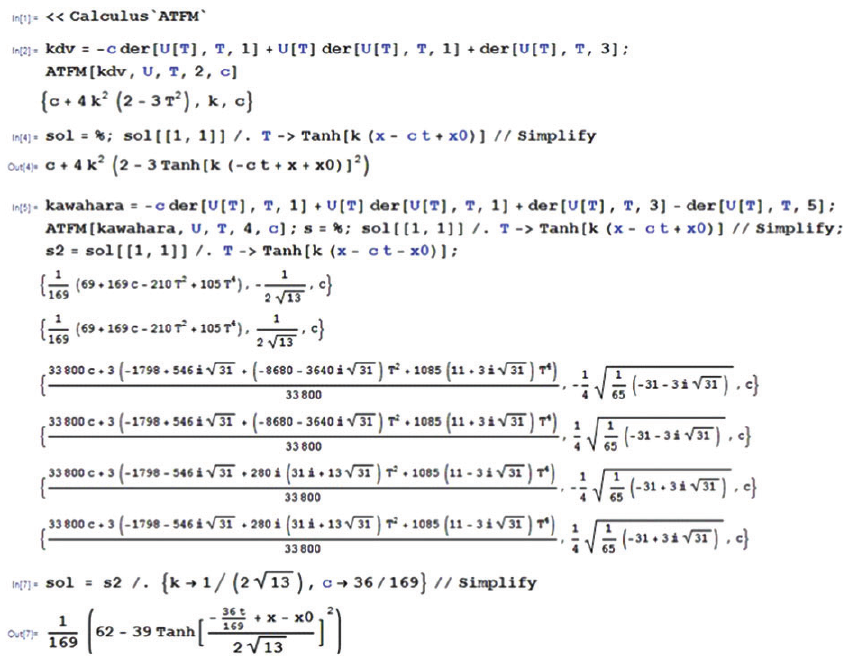
Figure 9 KdV and Kawahara PDE solutions by using the ATFM Mathematica ®